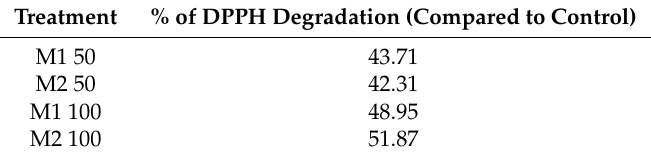
Table 3. Average percentage of 2,2-diphenyl-1-picrylhydrazyl (DPPH) degradation in coriander plants per